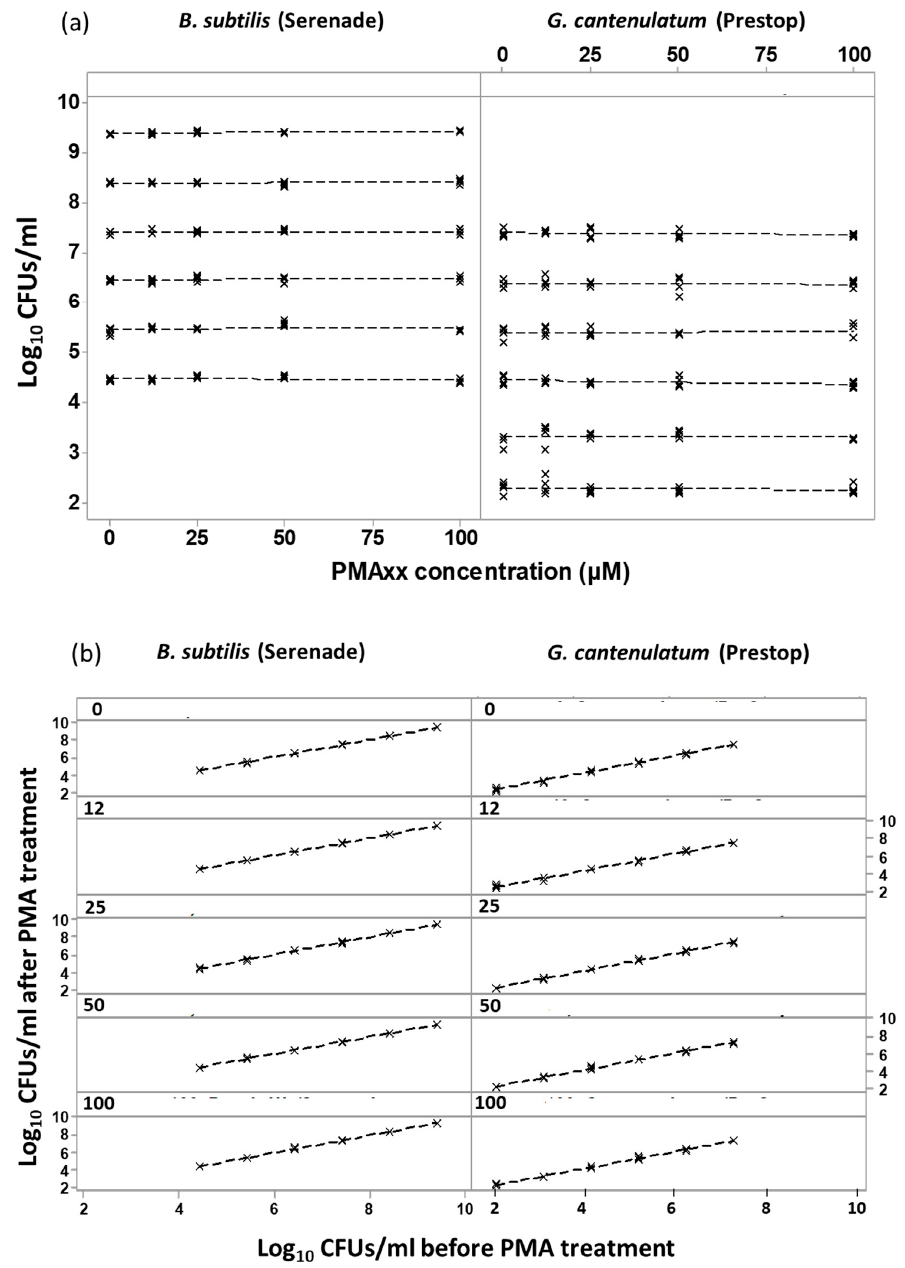
Figure 5. ( a ) Effect of increasing PMAxx™ dose on viable plate counts; ( b ) Linear standard curves of the relationship between CFUs mL − 1 before and after PMAxx™ treatment. The PMAxx™ concen- tration response with R2 values for B. subtilis are between 0–36%, while for G. catenulatum ranged between 0–16%. Each biological replicate was plated four times to confirm CFUs mL − 1 , and therefore each treatment combination contains four technical replicates. The standard error for each treatment was